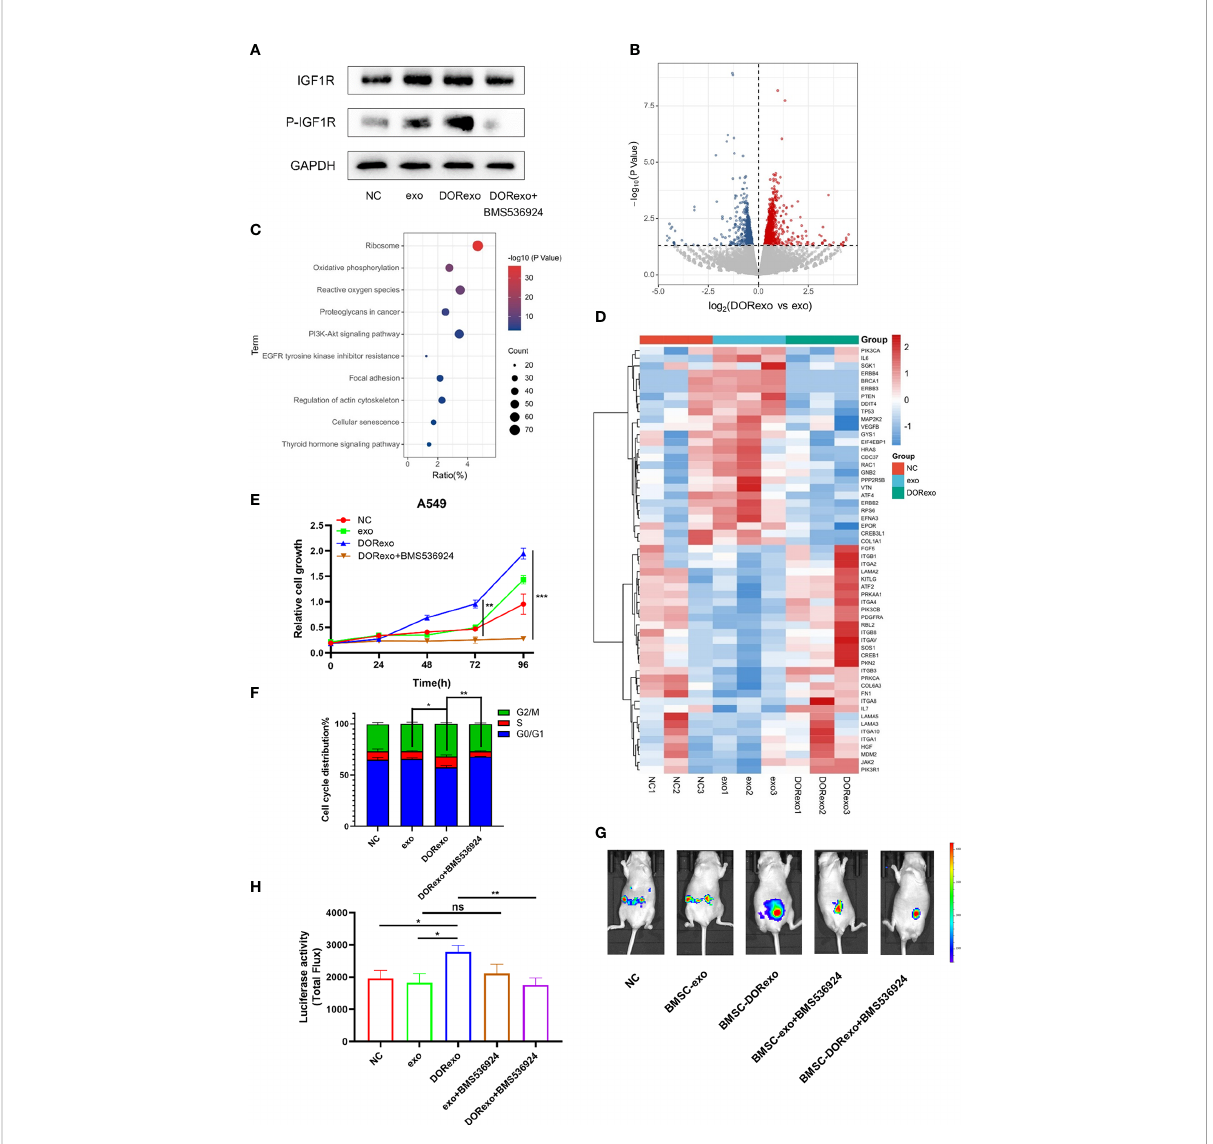
FIGURE 3 Exosomes derived from cisplatin-induced dormant A549 cells promote cancer cell growth by activating the BMSC IGF pathway. (A) Protein expressions of IGF-1R, p-IGF-1R were measured by Western blot analysis. (B) The volcano plots show differentially expressed genes (DEGs) between exo-treated BMSCs and DORexo-treated BMSCs based on RNA-seq (P < 0.05). (C) The bubble diagram showed KEGG pathway enrichment analysis for DEGs (0.5-fold, P < 0.05). (D) The heat map showed the signi fi cant differences involved in phosphoinositide 3-kinase (PI3K)-Akt signaling pathway and focal adhesion-related genes. (E) Cell viability of A549 cocultured with BMSCs treated with different exosomes and BMS-536924. (F) The ratio of cells with different cell cycles was represented in the histogram graph. S phase, *P < 0.05, **P < 0.01. (G) Animal imaging fl uorescence images. BMSCs that were incubated with exosomes were injected into the bone marrow cavity, and A549- luciferase cells were injected into the bone marrow cavity 3 days later. The growth and metastasis of A549 were evaluated by bioluminescence. IGF-1R inhibitor BMS-536924 was applied in the experiment. All mice were intramedullary injected with luciferase-labeled A549 cells. NC, mice without BMSC injection; MSC-exo, mice with injection of exo-treated BMSCs; MSC-DORexo, mice with injection of DORexo-treated BMSCs; MSC-exo+BMS-536924, mice with injection of exo-treated BMSCs and BMS-536924; MSC-DORexo+BMS-536924, mice with injection of DORexo-treated BMSCs and BMS-536924. (H) The activities of luciferase were shown in the histogram. *P < 0.05; **P < 0.01; ***P < 0.001. ns, no signi fi